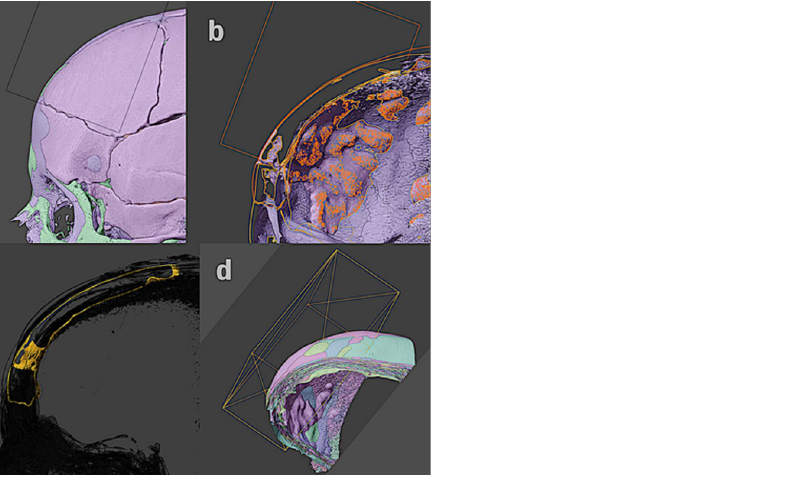
Fig 4. a-d. Phases of the alignment process between the digitised donors’ skulls with the one with the anatomical alteration studied in this article.